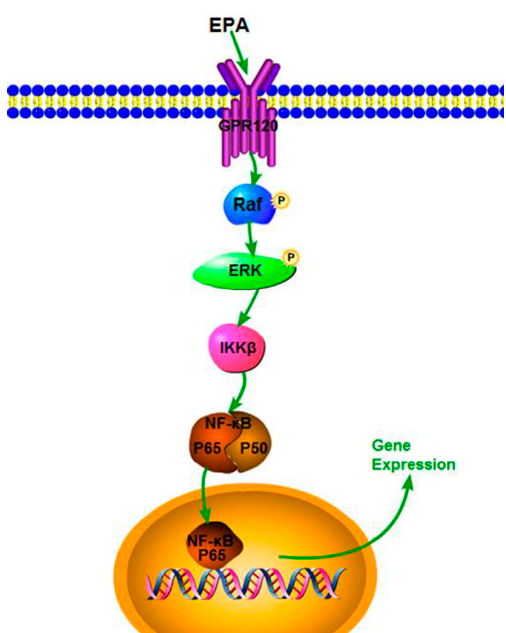
Figure 6. The sketch map of the RAW264.7 cells proliferation induced by EPA.